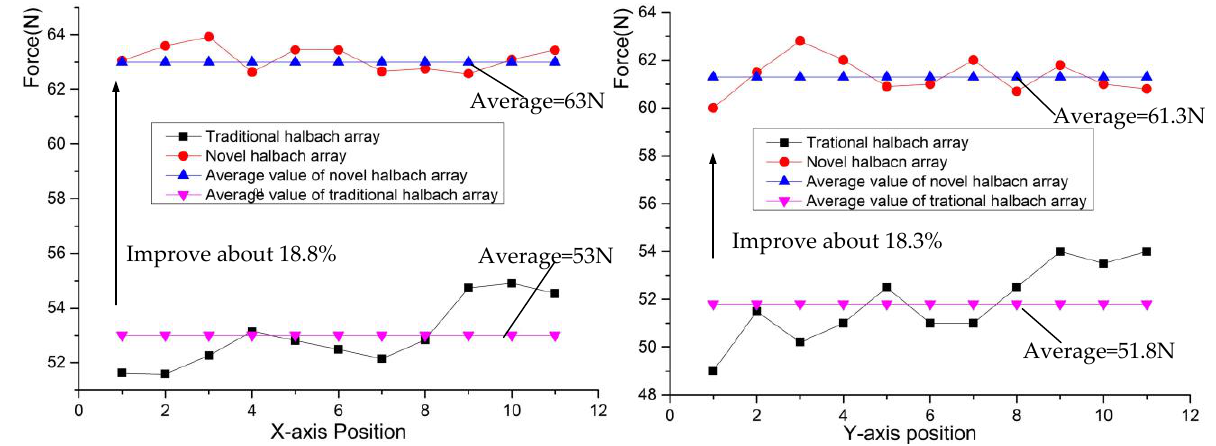
Figure 12. Relationship between the driving force and the actuator’s position .